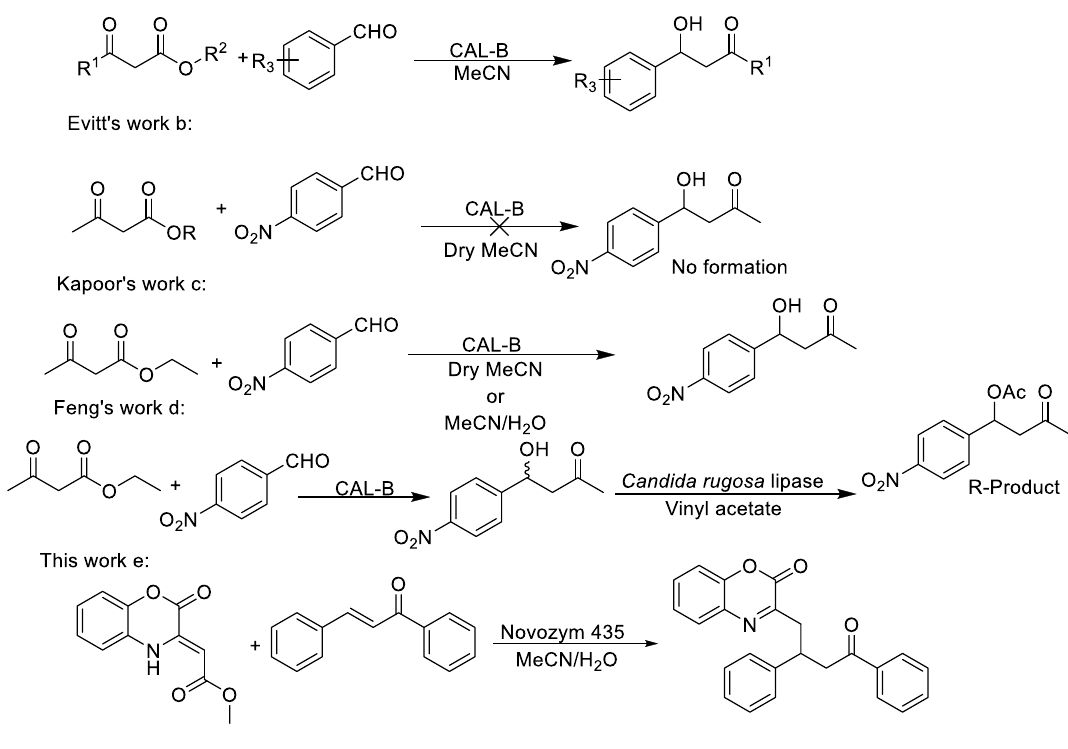
Figure 1. CAL-B catalyzed decarboxylative aldol and Michael